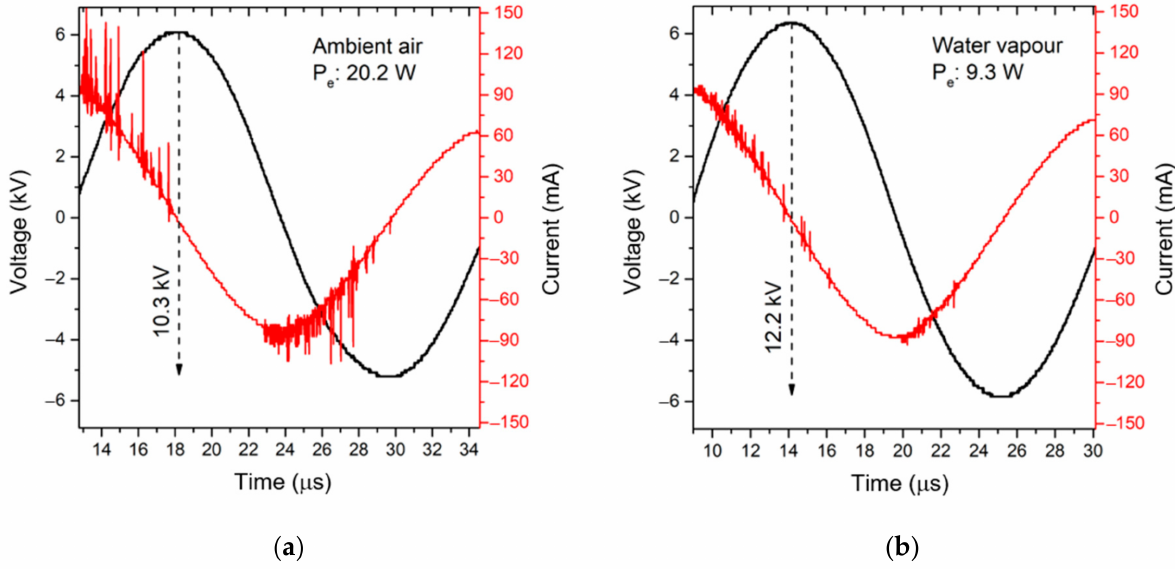
Figure 2. The voltage and current waveforms of MSDBD in ambient air (30 W) ( a ) and water vapor (26 W) ( b